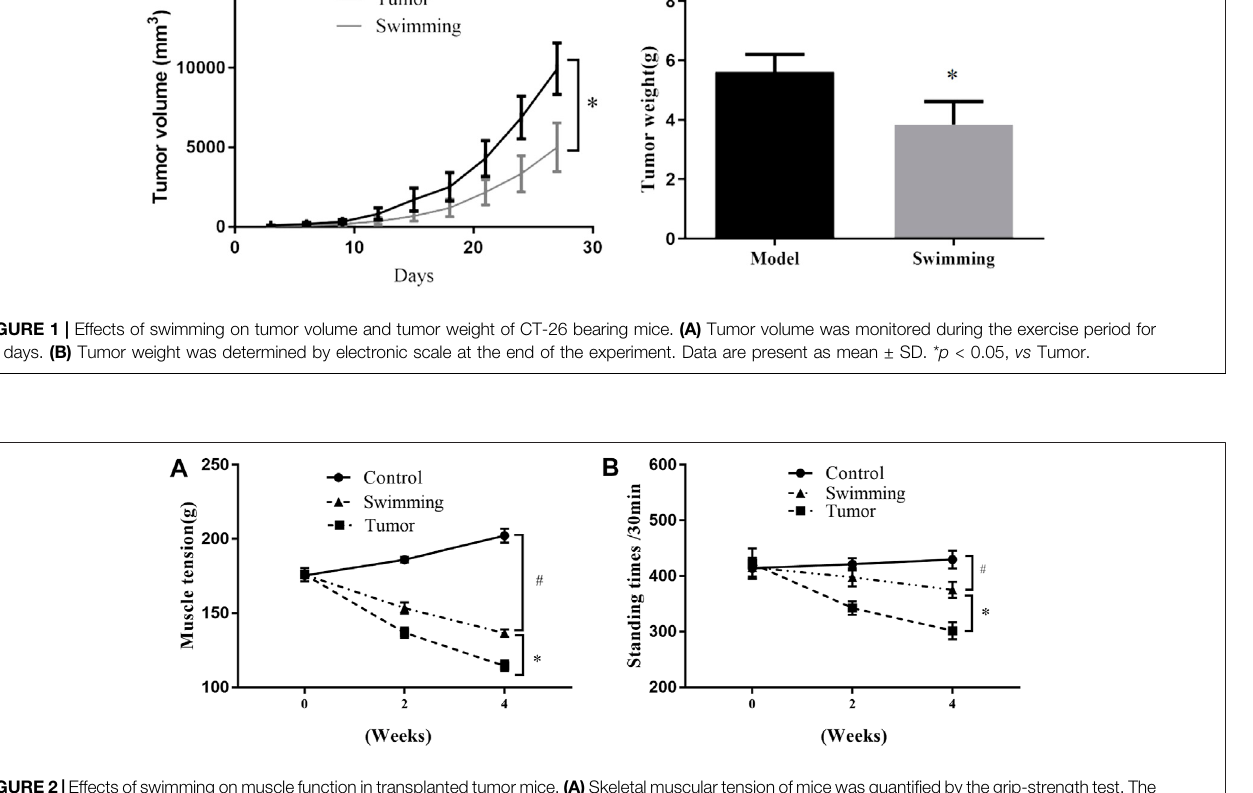
FIGURE2| Effectsofswimmingonmusclefunctionintransplantedtumor mice. (A) Skeletalmusculartensionofmice wasquanti fi edbythegrip-strengthtest. The strength test was performed before training, after the 2nd and 4th weeks of training. (B) Autonomic activity of mice was measured by the multifunctional mice independent activities recorder. The autonomous activity of the mice was recorded. Data are shown as mean ± SD. # p < 0.05, vs . Control; * p < 0.05, vs .